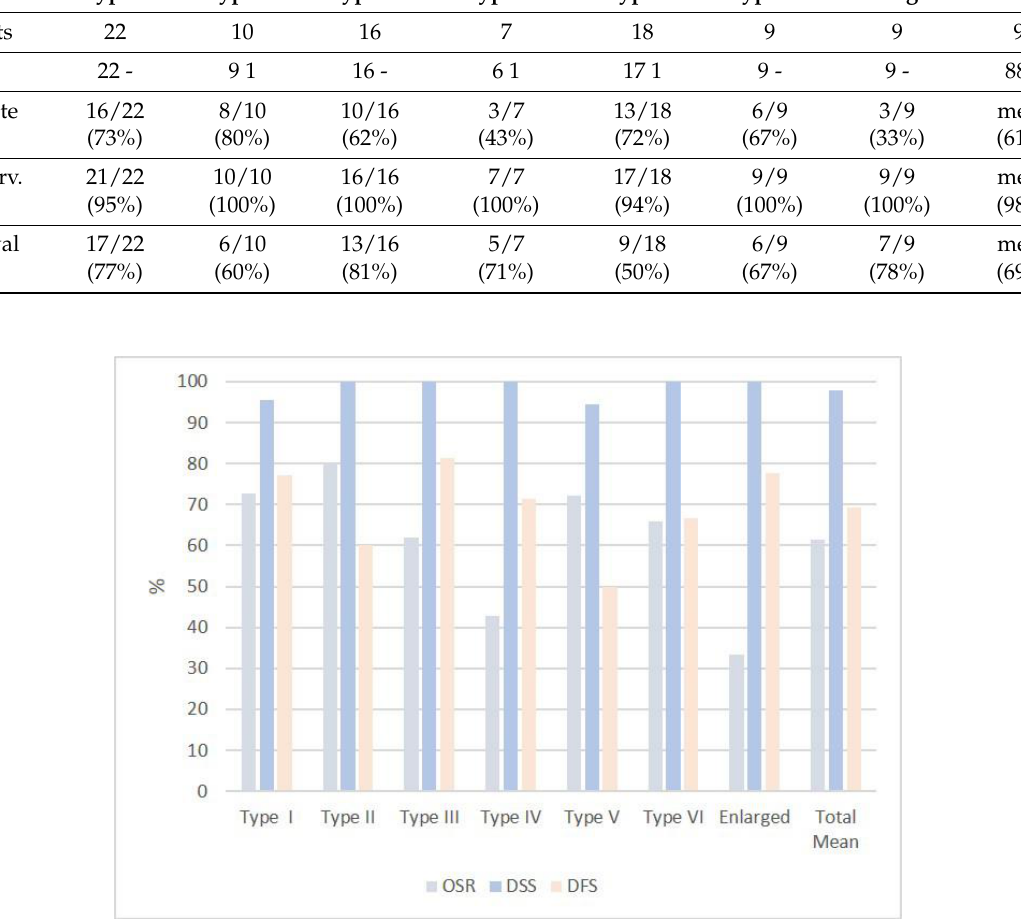
Table 4. Statistical analysis.